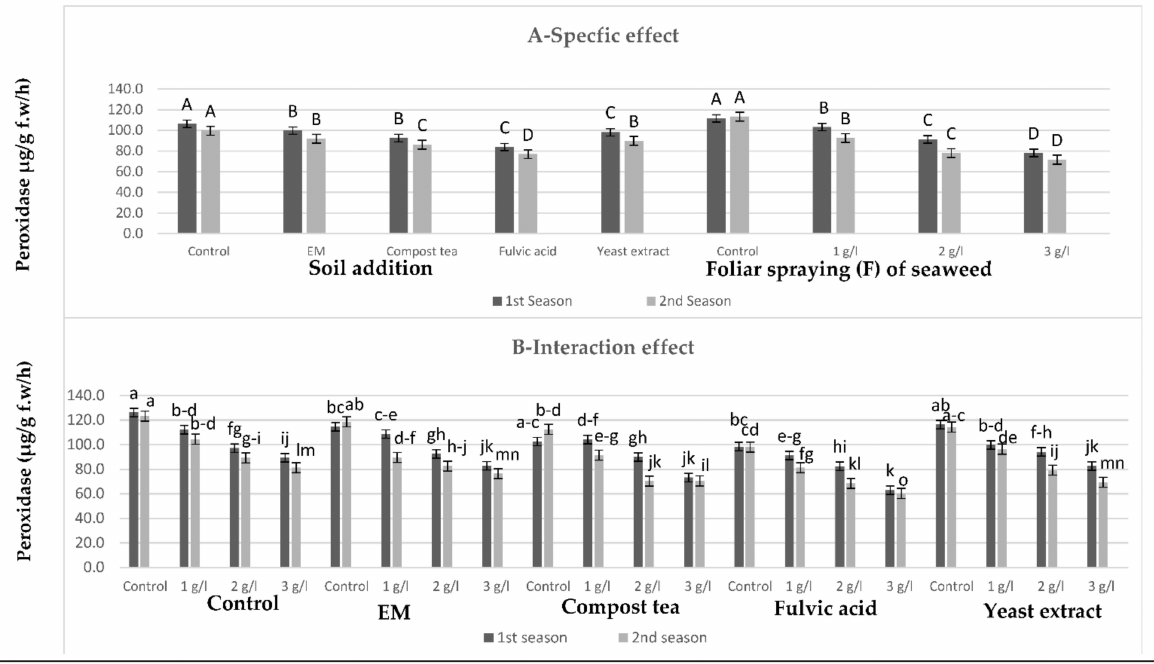
Figure 6. ( A , B ) Effects of soil addition of EM, compost tea, fulvic acid, yeast extract, and foliar spray with seaweed extract on peroxidase ( µ g/g f.w/h) of sweet pepper plants during the 2019/2020 and 2020/2021 seasons. Specific effects are indicated with uppercase letters and the interactions are indicated with lowercase letters, unless otherwise mentioned, according to Tukey’s multiple range test (TMRT) at p ≤